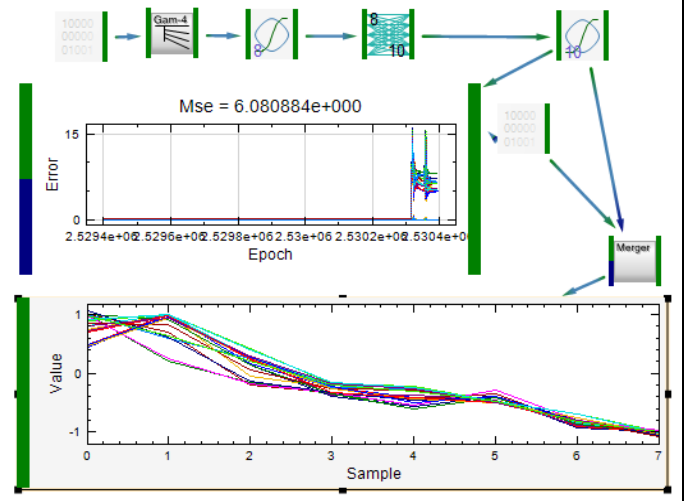
Figure 10. Schematic representation of gamma memory dynamic neural network